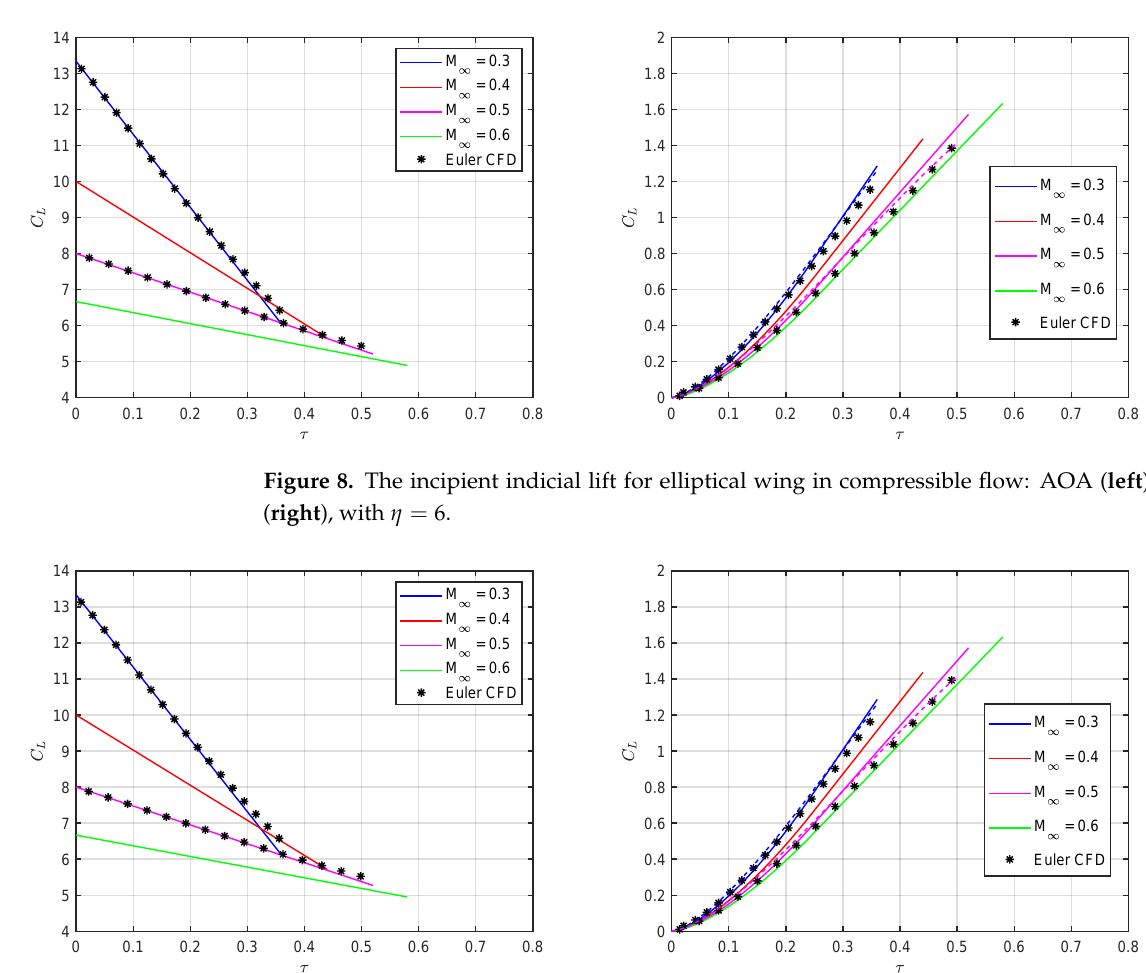
Figure 9. The incipient indicial lift for elliptical wing in compressible flow: AOA ( left ) and SEG ( right ), with η = 8.